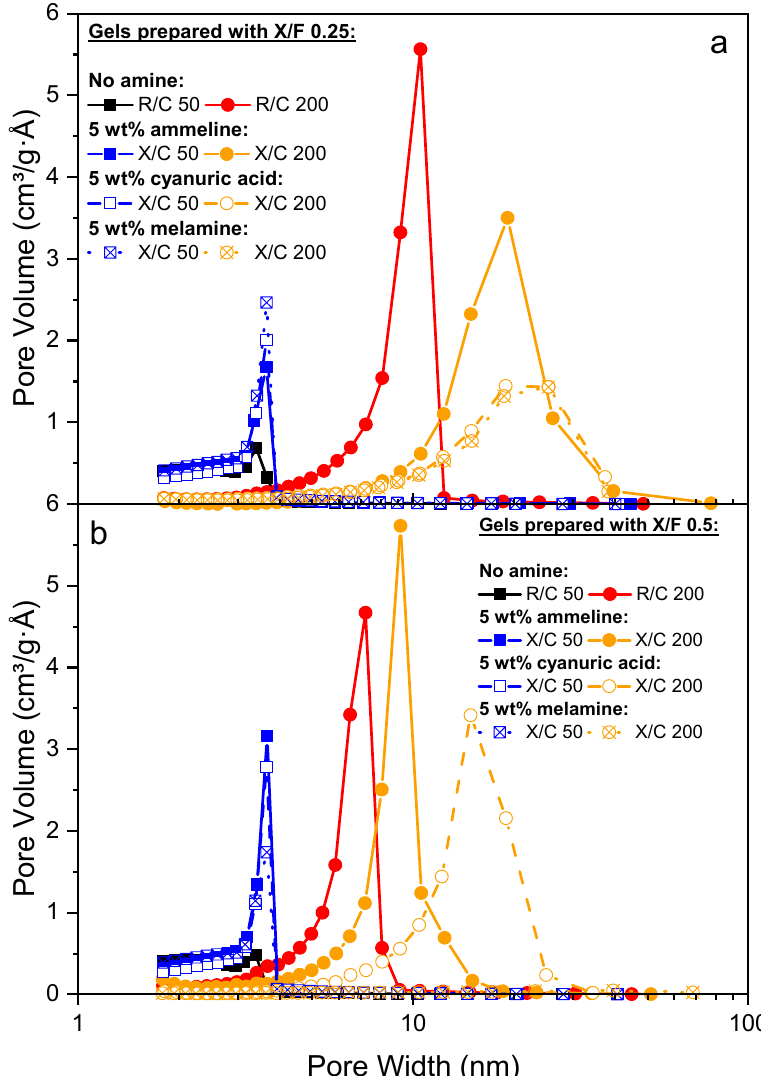
Figure 4. Pore size distributions for gels prepared with 5 wt% of additives with ( a ) X/F 0.25 and ( b ) X/F 0.5.